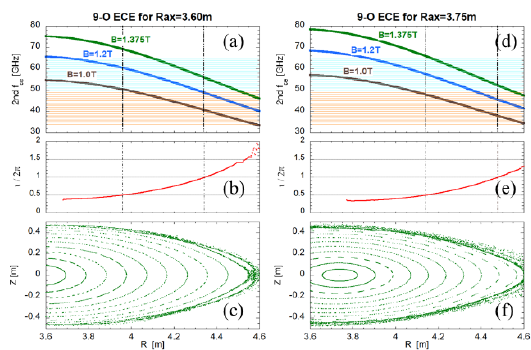
Fig. 11. (left) Radial distribution at Rax=3.60 m and (right) R ax =3.75 m. (a, d) Second harmonic cyclotron frequencies at B t =1 T, 1.2 T and 1.375 T. The orange and the light blue horizontal lines indicate the Q- and V-band measured channels’ frequencies, respectively. (b, e) Iota distribution (c, f) Magnetic closed flux surfaces for every ρ =0.1.